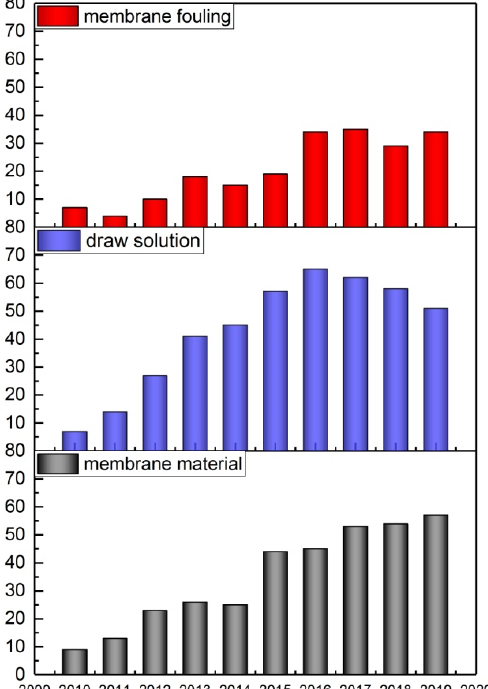
Figure 3. Number of papers in the three topics in the past 10 years.